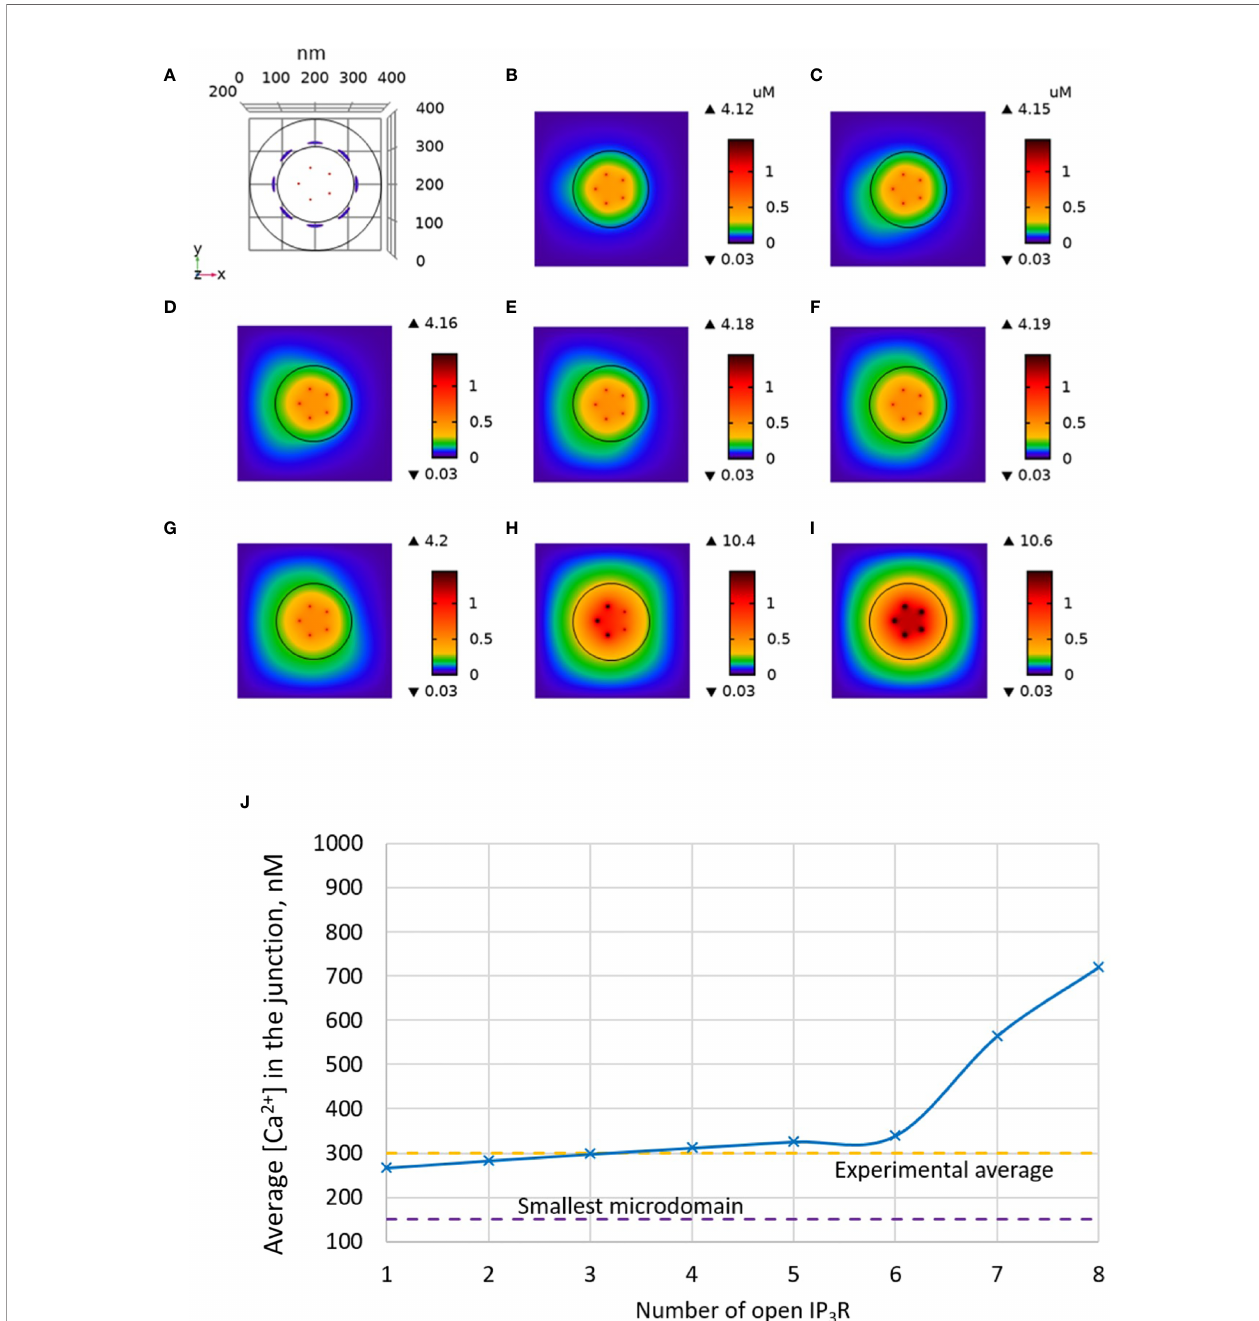
FIGURE 3 | Simulated Ca 2+ microdomains resulting from the opening of the IP 3 Rs adjacent to the junctions, which in turn induces the opening of ORAI1 channels in the junctions as a result of local depletion of ER Ca 2+ . (A) Upper view of the arrangement of the ORAI1 channels on the PM of the junction (red dots) and of the adjacent IP 3 Rs (blue lines) using COMSOL. (B – I) Steady-state Ca 2+ pro fi les in the junction when opening 1 (B) to 8 (I) IP 3 Rs simultaneously. Left bars indicate the color codes, together with the minimal and maximal concentrations reached in the related panel. Shown are the pro fi les 22ms after opening of the IP 3 Rs. Upon depletion of local Ca 2+ in the ER, which is quasi-instantaneous, ORAI1 channels open to an extent that depends on this local concentration, as de fi ned by the function f (see Supplementary Information ). ORAI1 opening is assumed to occur immediately after depletion because ORAI1-STIM2 aggregates are pre-formed (4). (J) Evolution of the amplitude of the simulated Ca 2+ microdomains with the number of simultaneously open IP 3 Rs in the junction, showing that experimentally observed microdomains can in principle result from the opening of ORAI1 channels induced by the spontaneous opening of a few IP 3 Rs near the junction, in conditions of a full